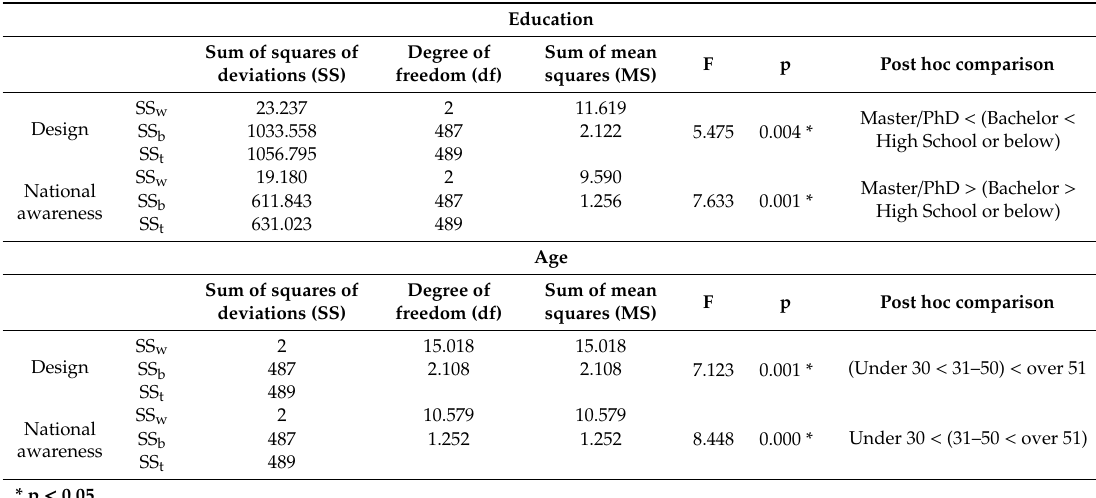
Table 10. Summary of one-way